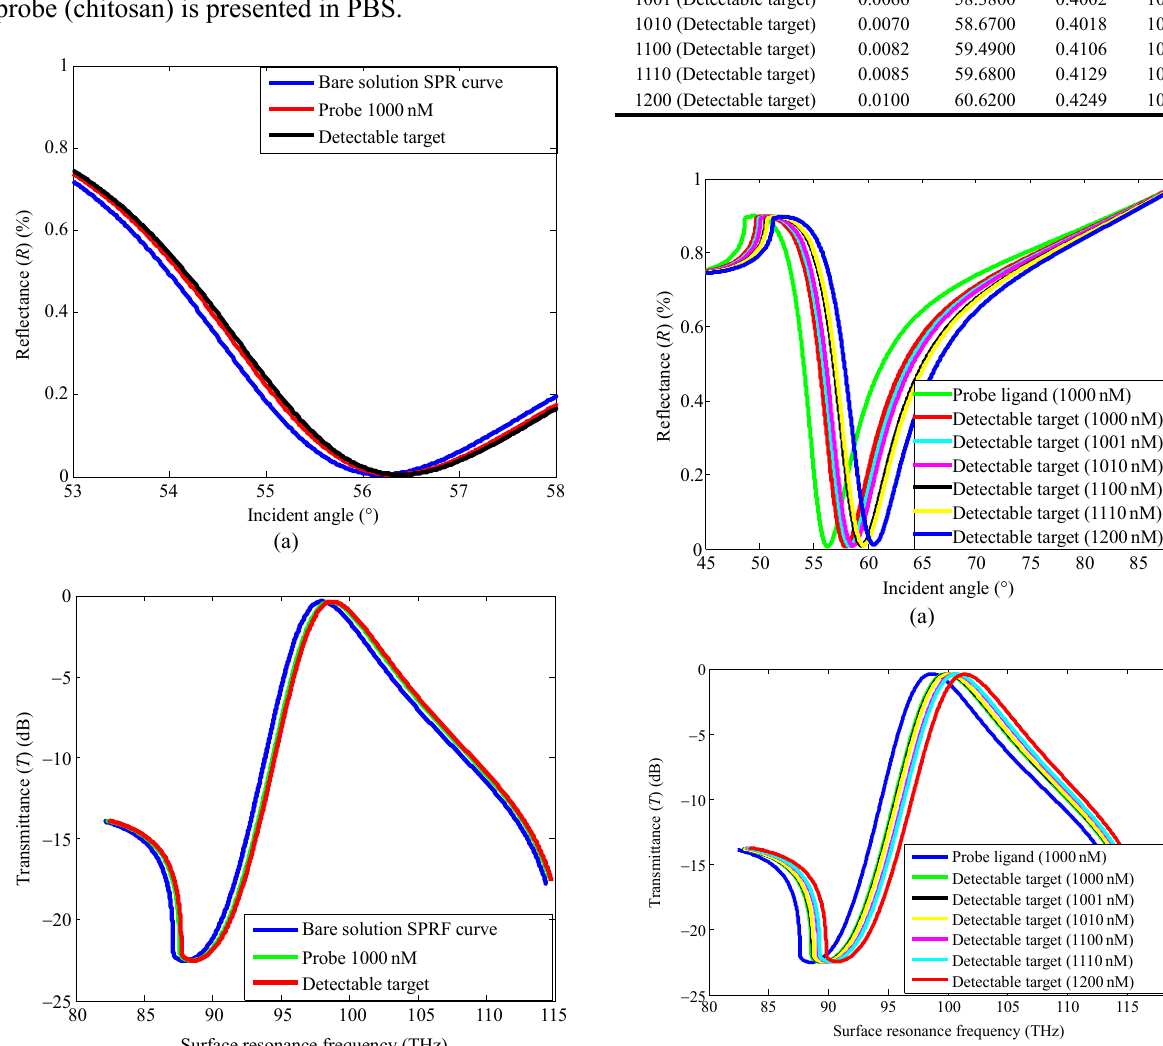
Table 2 Data of detecting attributors R min (%),  SPR (deg),